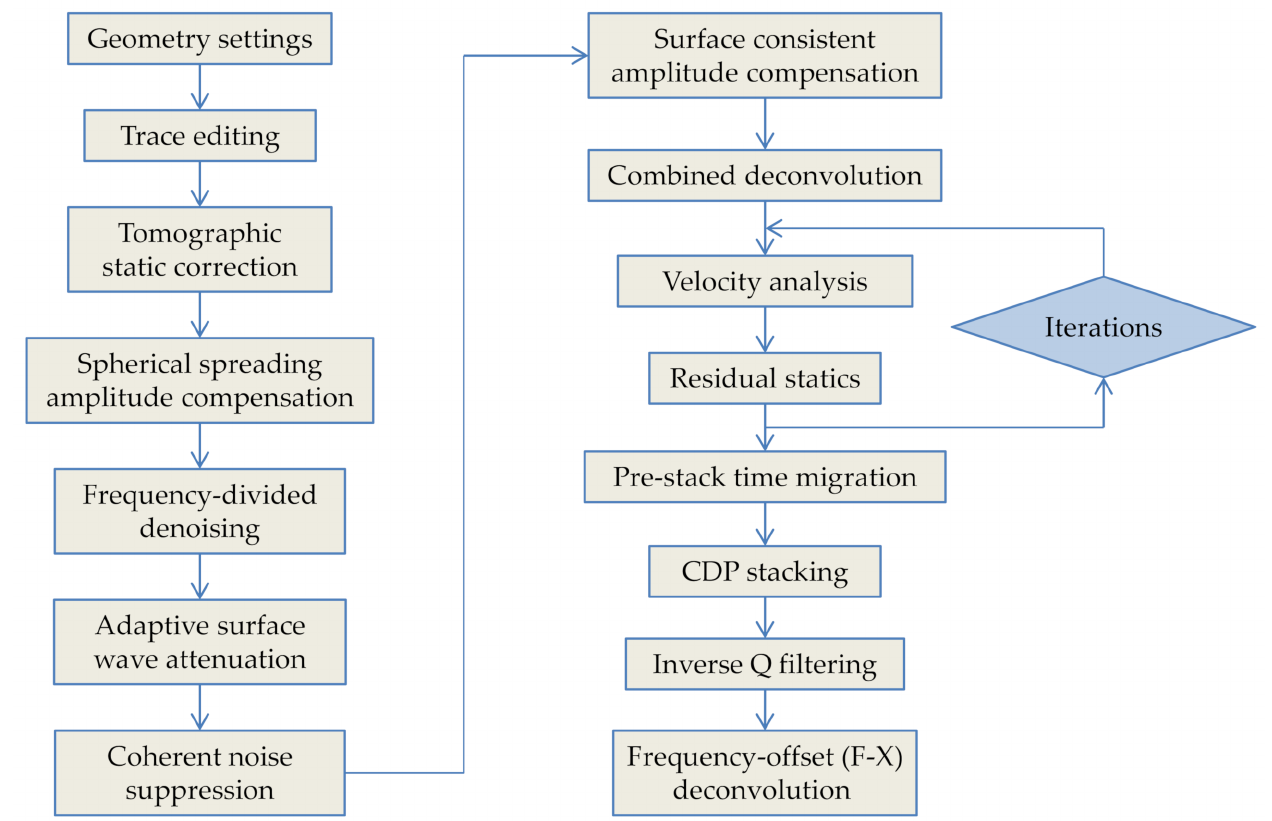
Figure 2. Processing workflow for 3D seismic data of a sandstone-type uranium deposit (modified from Wu et al.